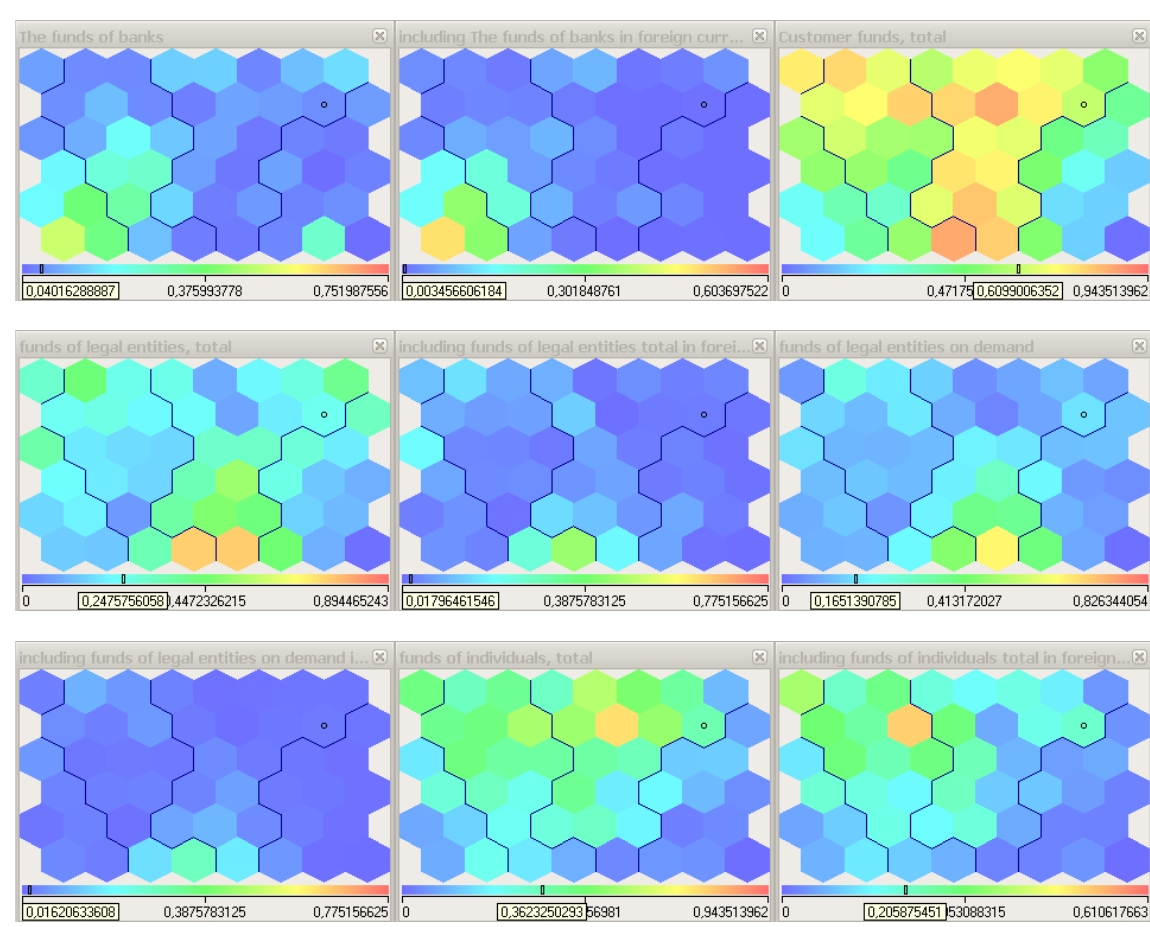
Figure 4. SOM (2014-2017). Kohonen maps for selected indicators of bank